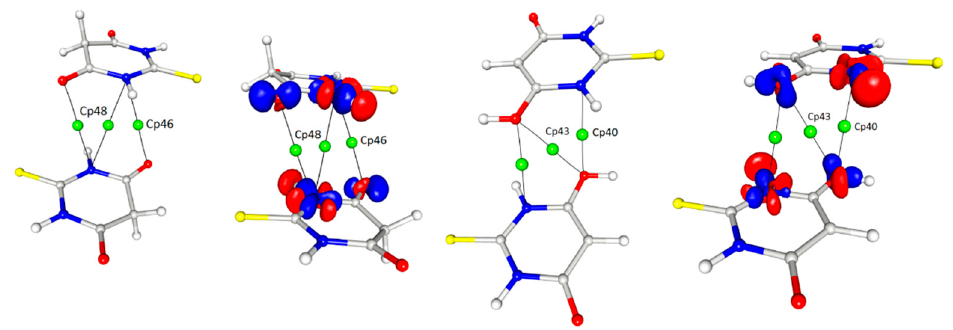
Figure 8. Contact between the oxygen atoms of both the ketone and enol forms with the nitrogen